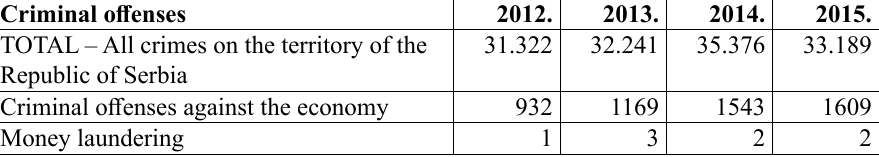
Table 2. Number of convicted adults for crimes against the economy and the total for all crimes on the territory of the Republic of Serbia in the period